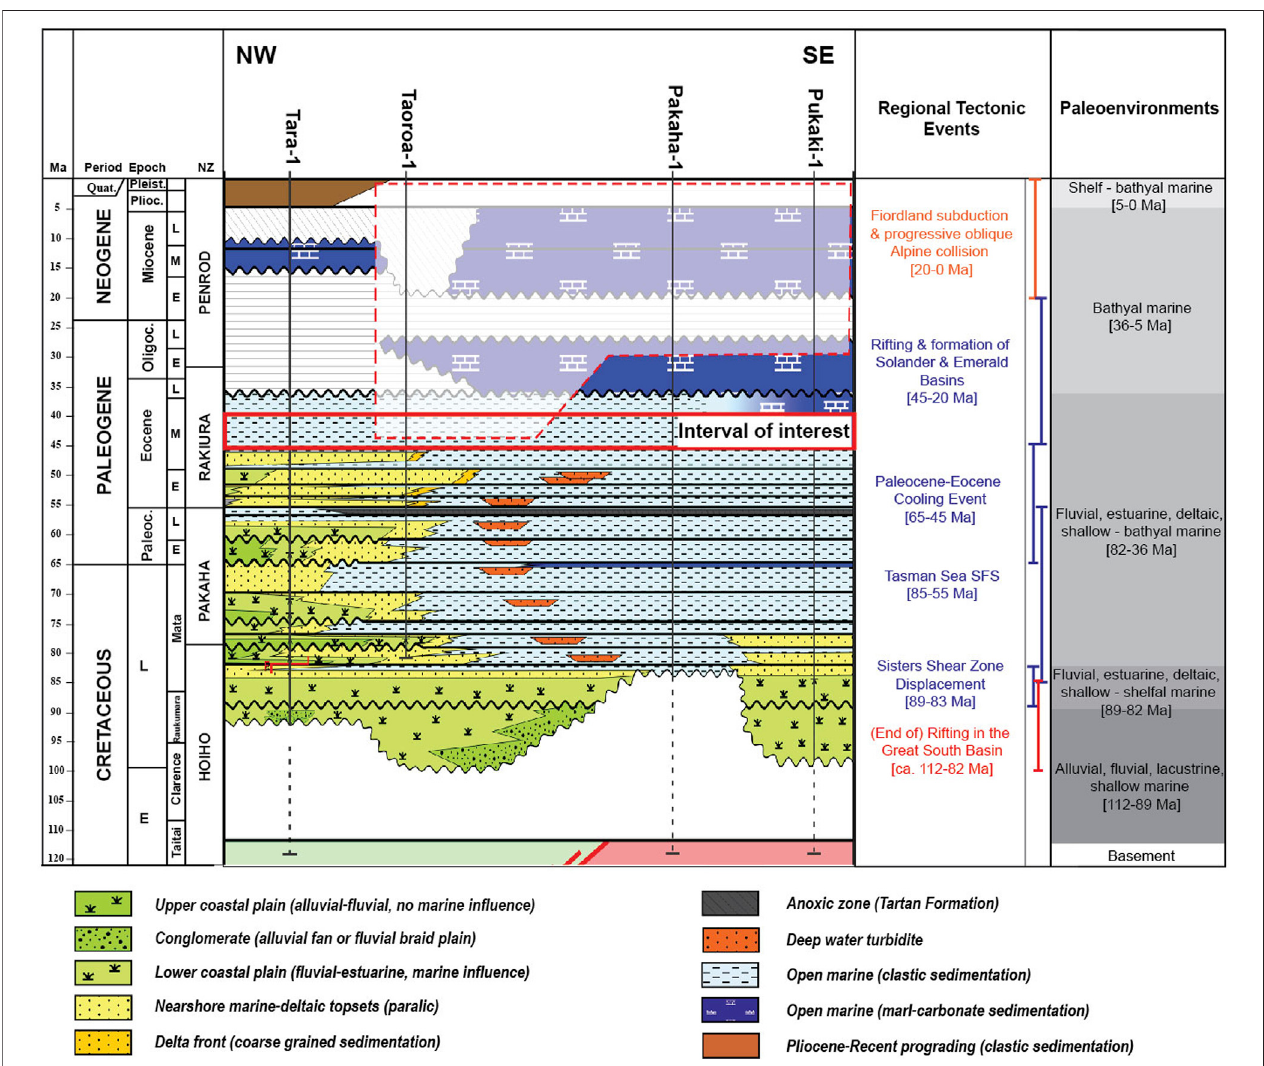
FIGURE 4 | Stratigraphic framework of the Great South Basin including paleoenvironments and tectonic events. The red rectangle highlights the Laing Formation which is the paleo-pockmark interval. Compiled and modi fi ed from Constable et al. (2013).